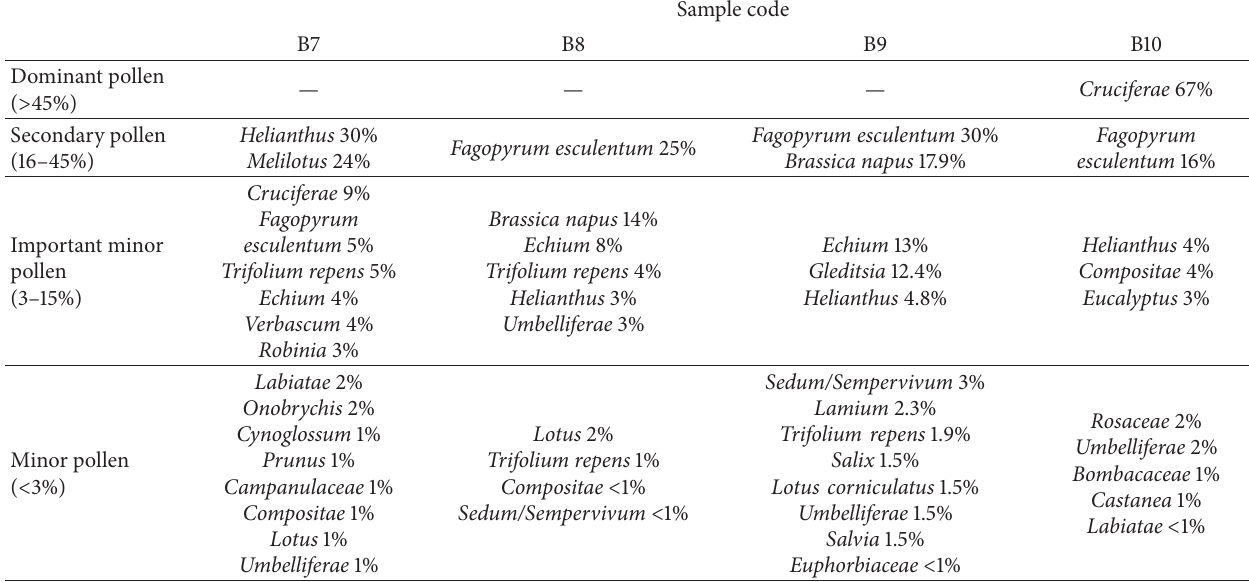
Table 3: Relative frequencies of the main pollen types in honeys labeled as buckwheat honeys. B7: buckwheat honey from Russia; B8 and B9: buckwheat honey from Poland; B10: buckwheat honey from